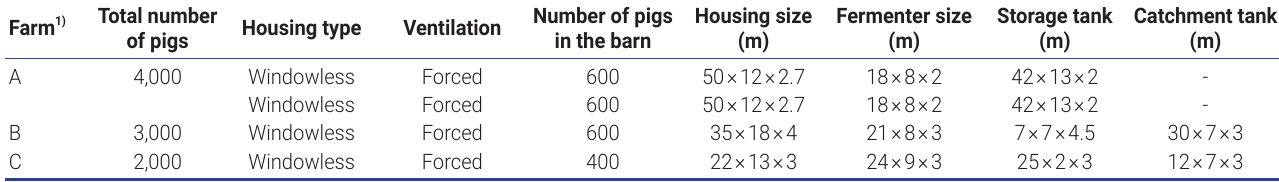
Table 1. Conditions of experimental swine houses Farm 1)